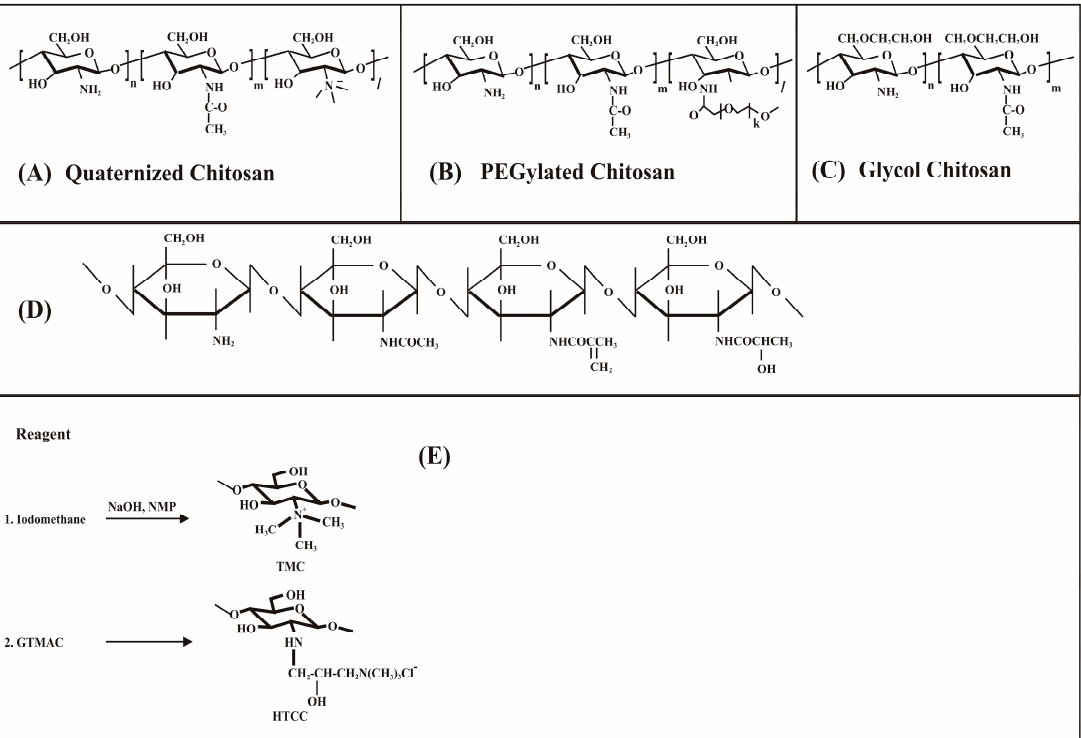
Figure 3. Various structures of modified chitosan in combination with other compounds. ( A ) quaternized chitosan ( N , N , N trimethyl chitosan); ( B ) water-soluble polyethylene-glycol conjugated chitosan; ( C ) glycol chitosan containing short ethylene glycol groups [46]; ( D ) water-soluble and cross-linkable chitosan derivative obtained by grafting methacrylic acid and lactic acid onto the pendant amine groups of chitosan [47]; ( E ) quaternized chitosan modified using glycidyl trimethyl ammonium chloride (GTMAC) for protein delivery [48].